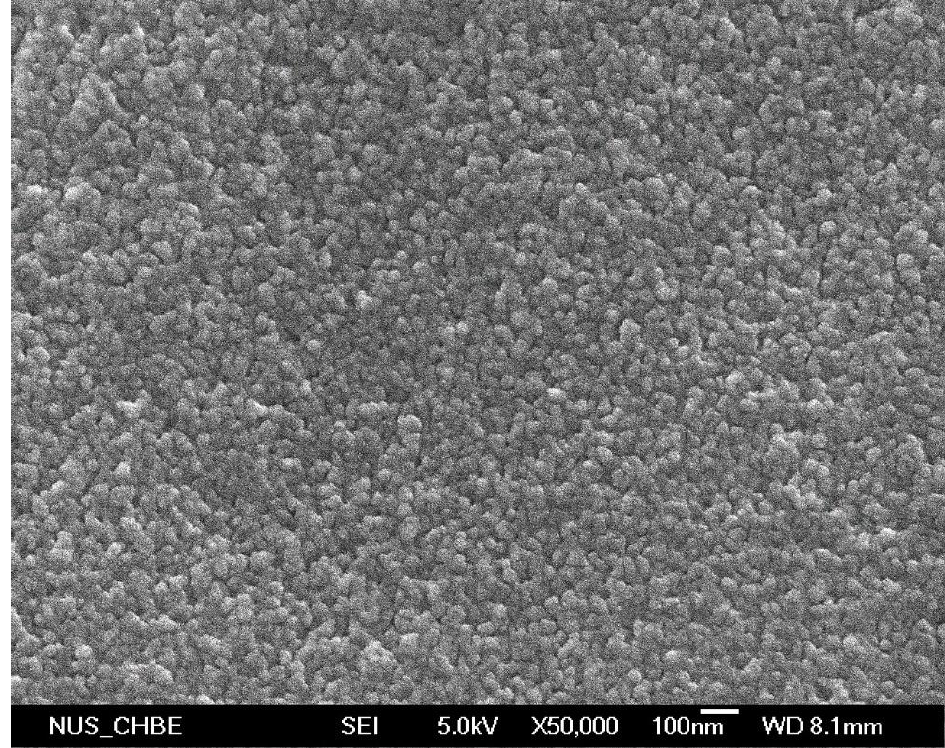
Figure A1. FE-SEM images of cross-linked diblock A50G4S-10 membrane (magnification 50,000×).